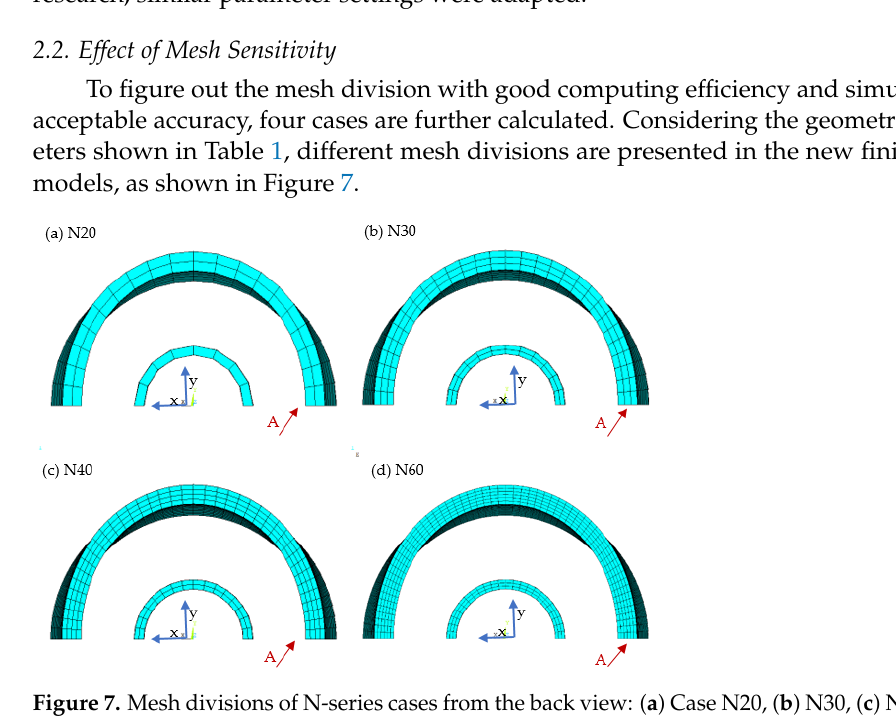
Figure 7. Mesh divisions of N-series cases from the back view: ( a ) Case N20, ( b ) N30, ( c ) N30, ( d ) N60.